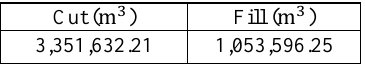
Table 6. Volume of earthworks required for the improvement of